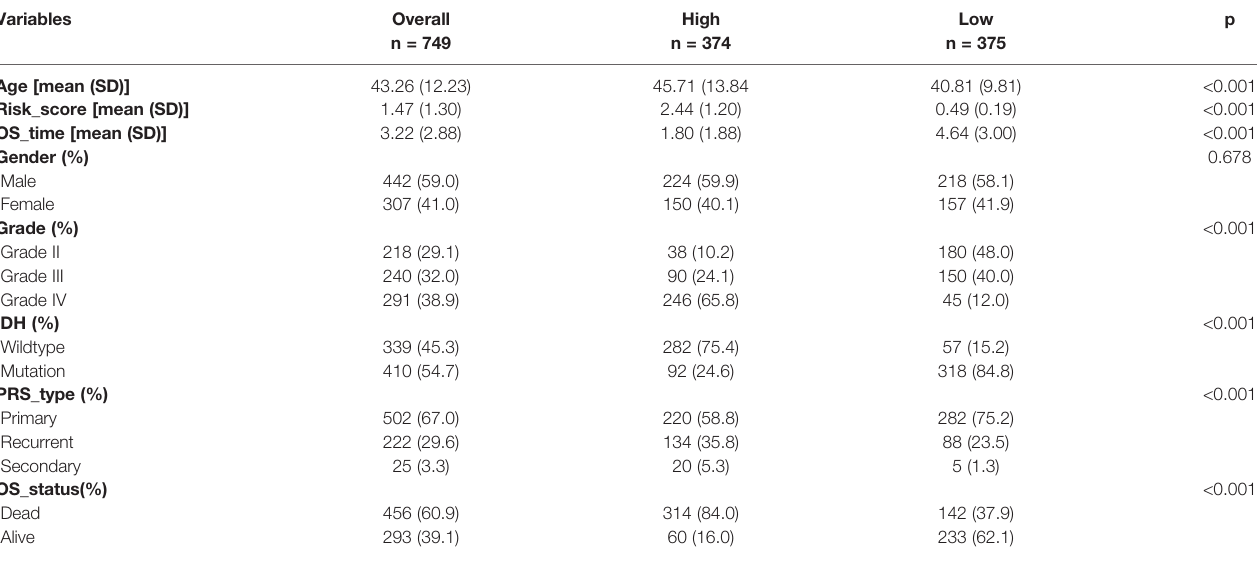
TABLE 1 | Differences in clinical features among immune subtypes of glioma. Variables Overall